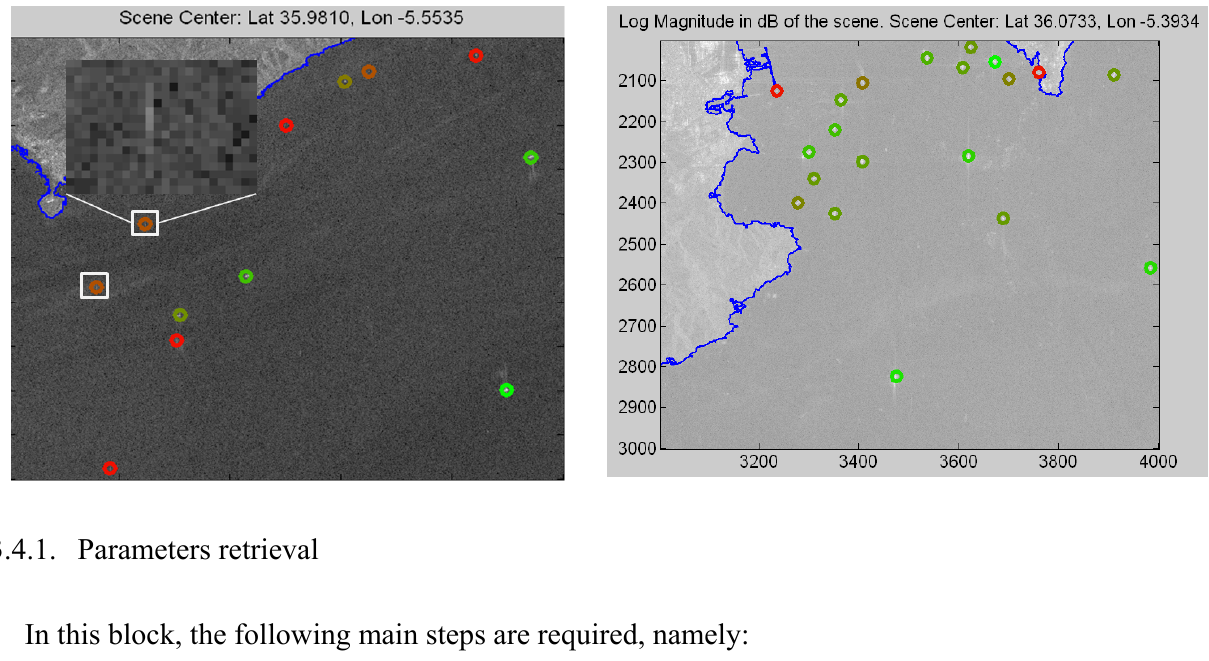
Figure 4. Snapshots of ship detection performed by SIDECAR for two sections of an ENVISAT image of the Strait of